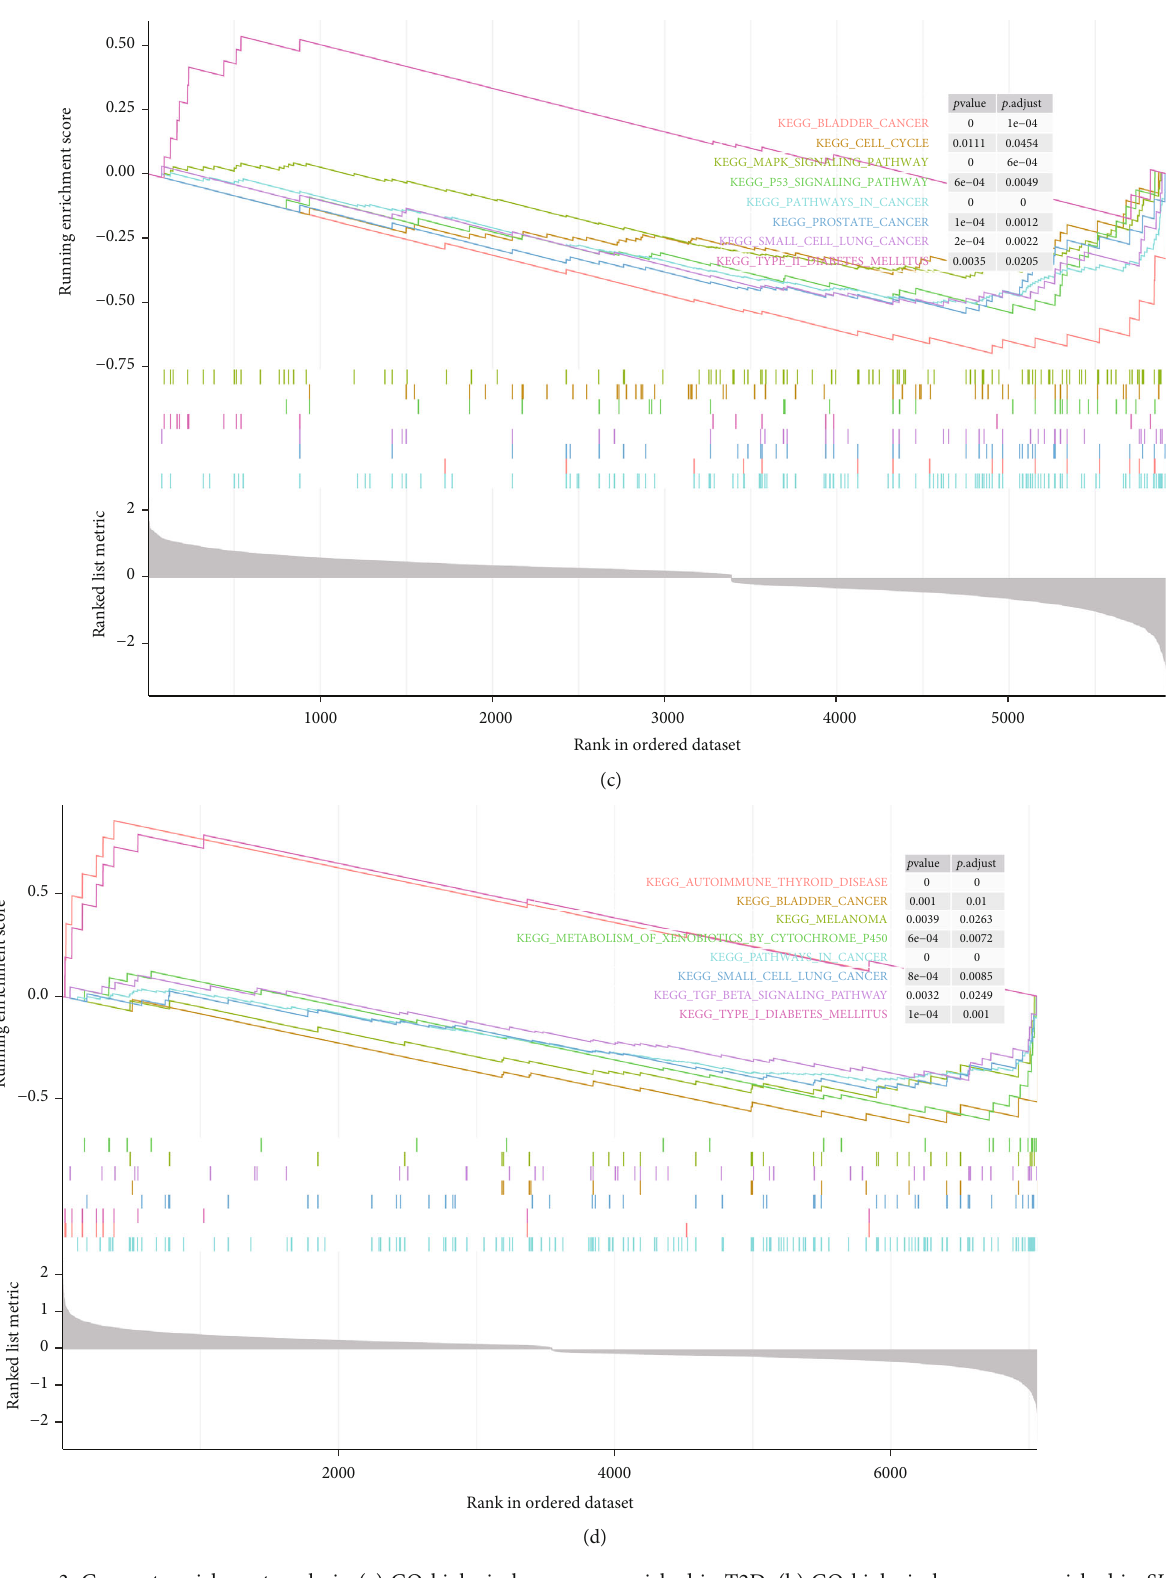
Figure 3: Gene set enrichment analysis. (a) GO-biological processes enriched in T2D. (b) GO-biological processes enriched in SLC24A2 - high. (c) KEGG pathways enriched in T2D. (d) KEGG pathways enriched in SLC24A2 -high. GO: Gene Ontology; KEGG: Kyoto Encyclopedia of Genes and